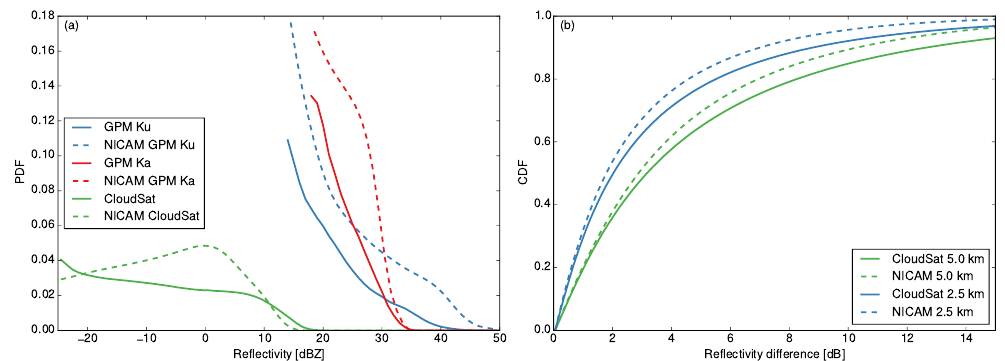
Figure 2. NICAM simulation results for CloudSat and GPM compared to measurements by those satellites. (a) The distributions of radar reflectivity. The curves are normalized such that the area under each curve for the measurements is equal to 1, while the modeled curves are scaled to reflect the difference in the total number of detected signals between the model and the measurements. (b) The cumulative distribution functions (CDFs) of W-band reflectivity difference between points separated horizontally by 5.0km (green curves) and 2.5km (blue curves), for CloudSat measurements (solid lines) and for our model (dashed